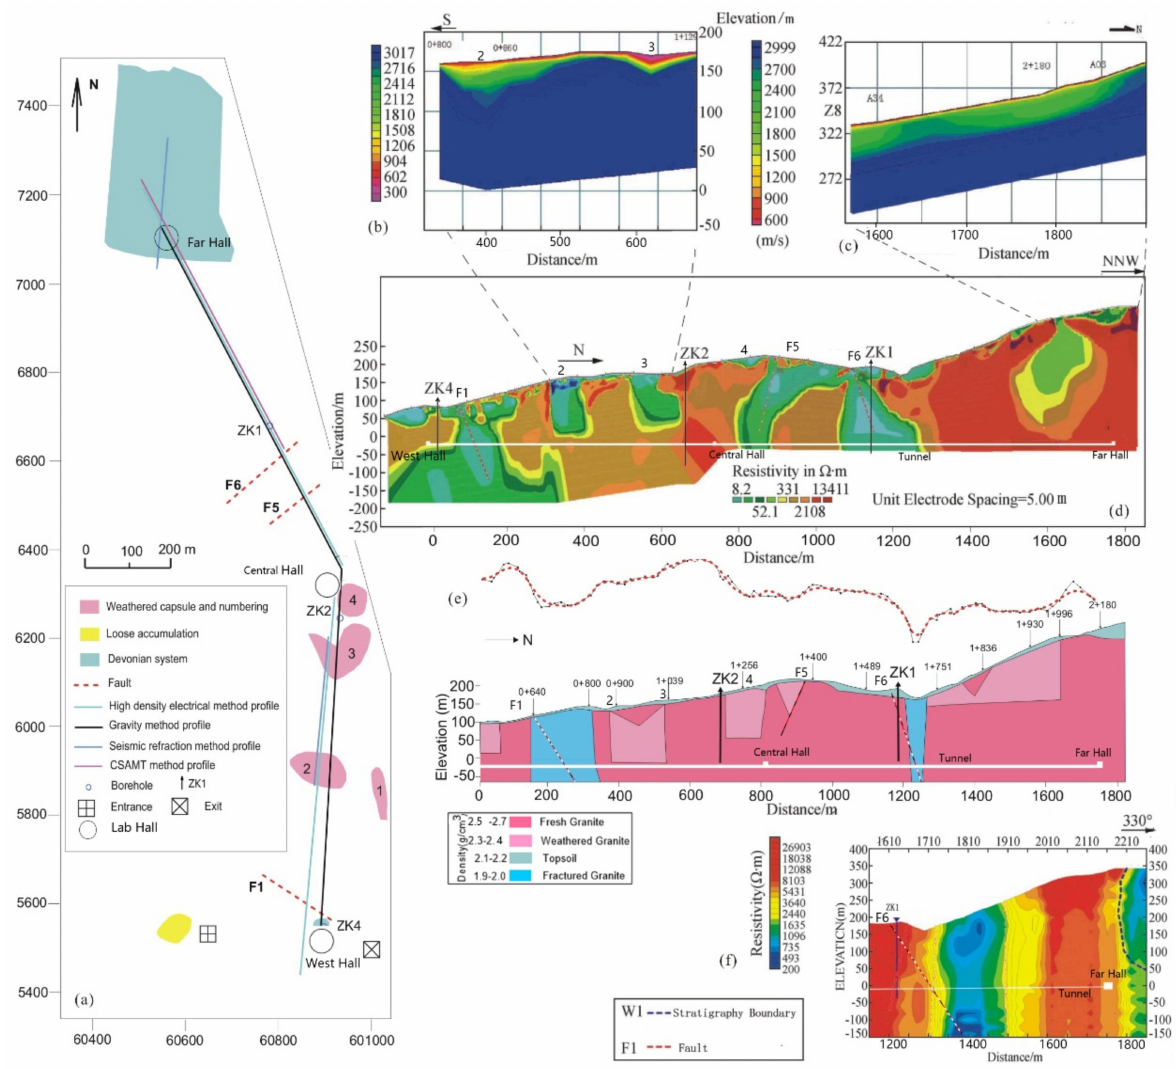
Figure 3. Geophysical exploration surveys and interpreted profiles at the DBNL site. ( a ) Layout of the geophysical exploration profiles along the tunneling line. ( b – f ) Interpreted profiles using different geophysical methods, such as seismic refraction analyses of the ( b ) mid hall and ( c ) far hall, ( d ) electrical resistivity tomography analyses of the west and far halls, ( e ) gravimetric analyses, and ( f ) electromagnetic resistivity analyses